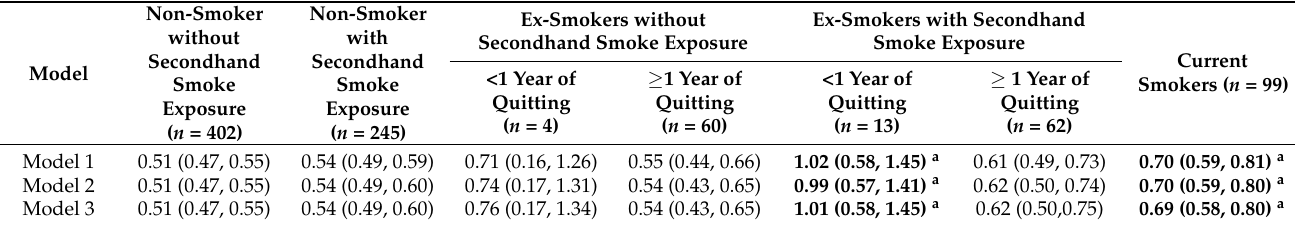
Table 3. Regression analysis associations of adjusted geometric mean cadmium ( µ g/g-creatinine) (95% CI) among different self-reported smoking